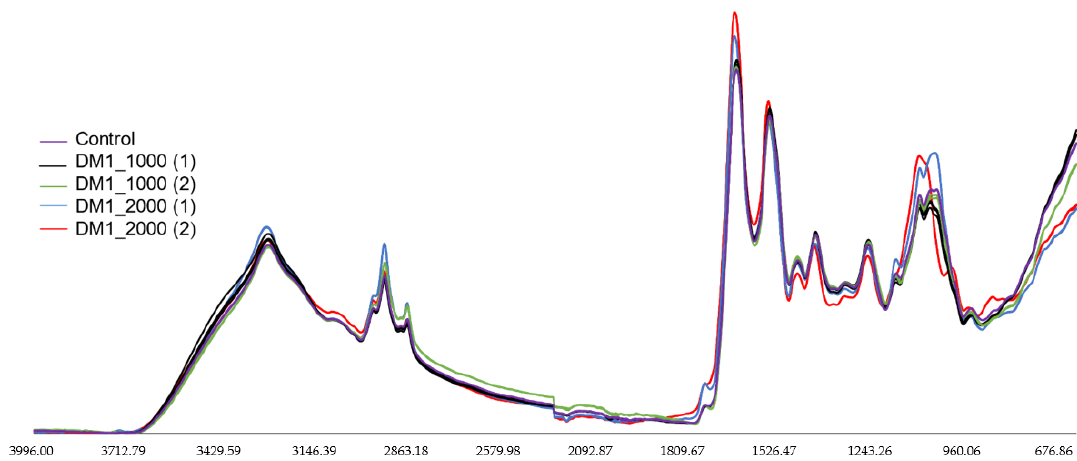
Figure 1. FTIR spectra of DM1-derived fibroblasts and control from Coriell Institute. Baseline-corrected and area normalized spectra of DM1-derived fibroblasts and control in the 4000–600 cm − 1 region. X -axis:wavenumber cm − 1 , Y -axis: arbitrary units